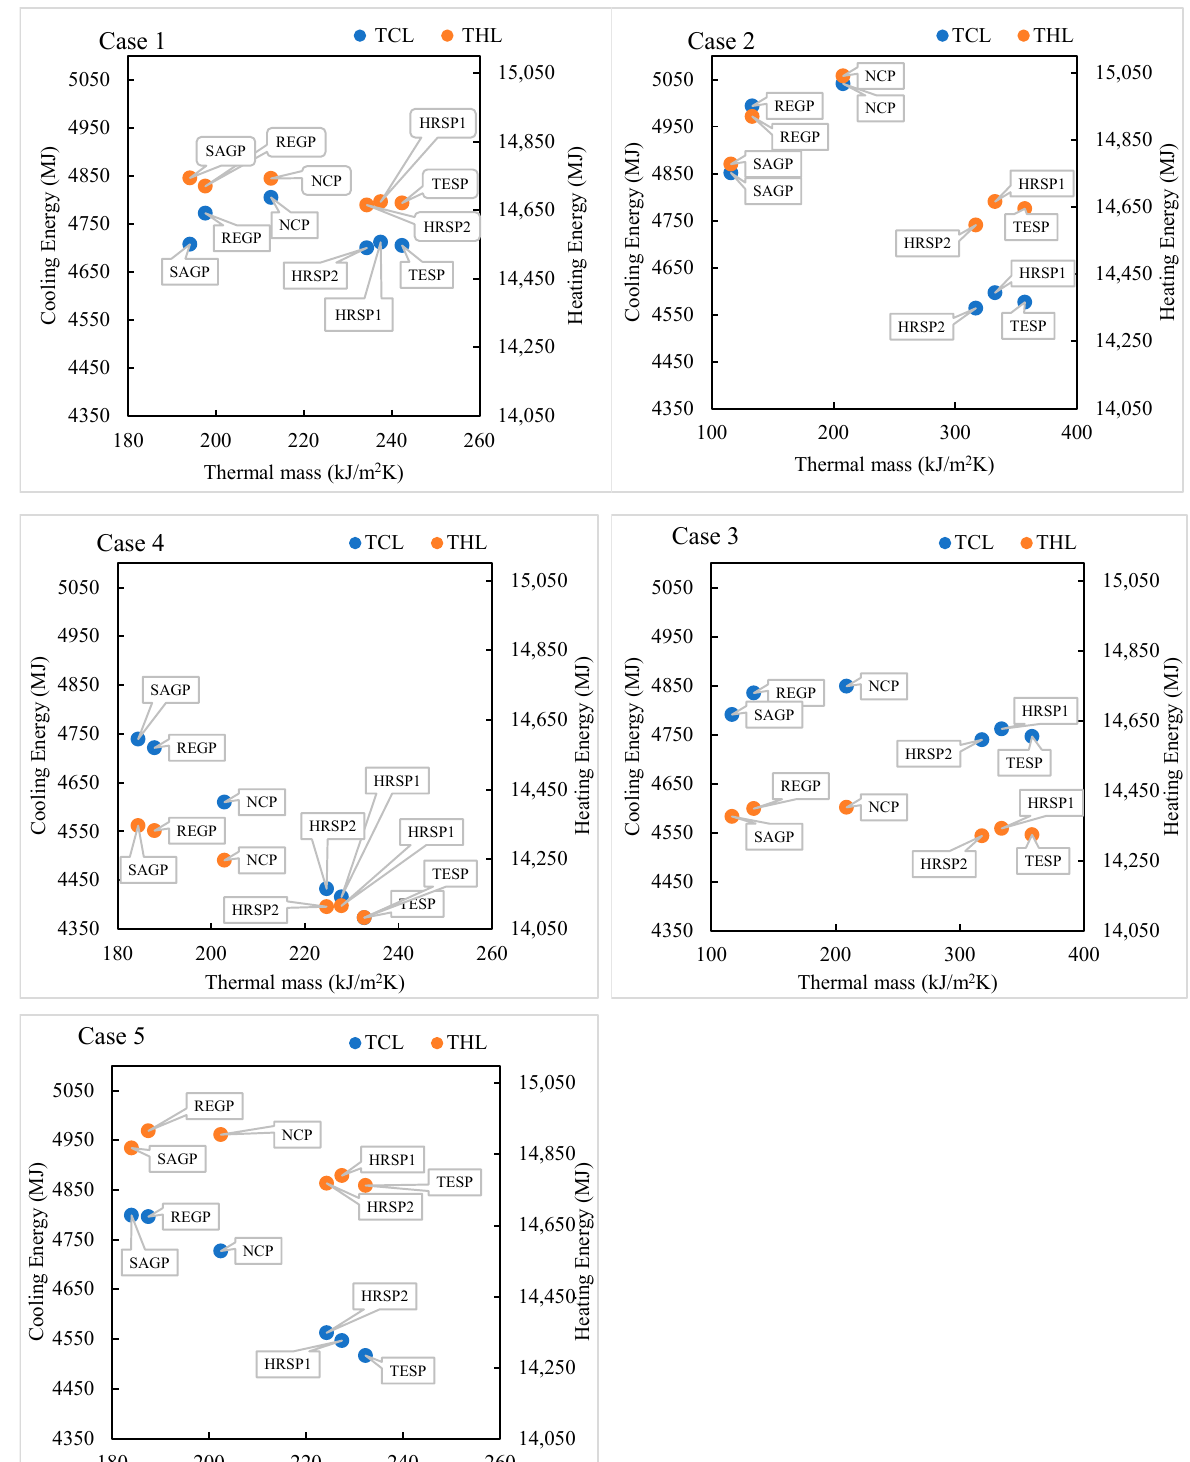
Figure 11. Effect of external wall thermal resistance on (a-b) operation energy consumption (cooling and heating).